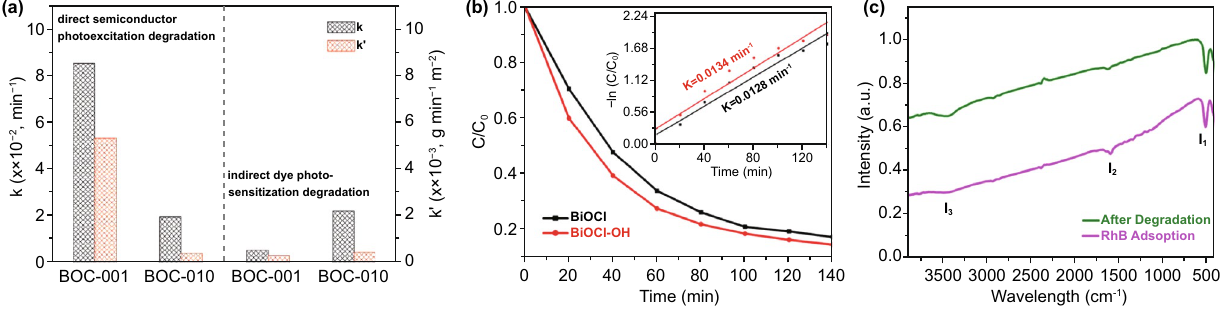
Fig. 6 Catalytic degradation applications of 2D nanomaterials. a Direct semiconductor photoexcitation pollutant degradation in single-crys- talline BiOCl nanosheets under UV light. Reproduced with permission [332]. Copyright 2012, American Chemical Society. b, c BiOCl and BiOCl-OH photocatalyst for UV light driven photocatalytic dye degradation. Reproduced with permission [333]. Copyright 2017, American Chemical